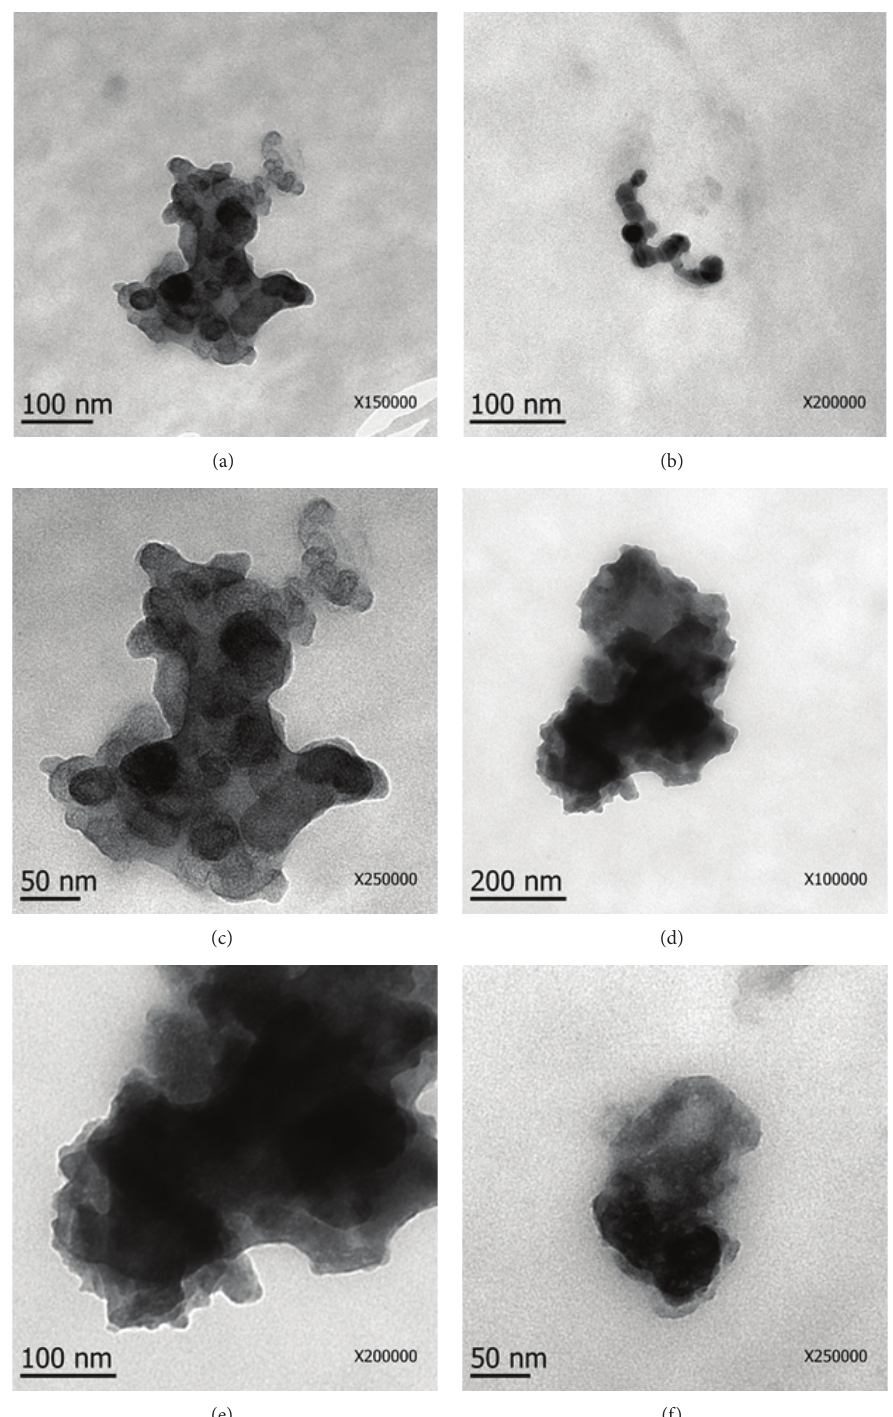
Figure 3: TEM images of silica particles obtained for annelids bioprocess (a–c) and without bioprocess (d–f).